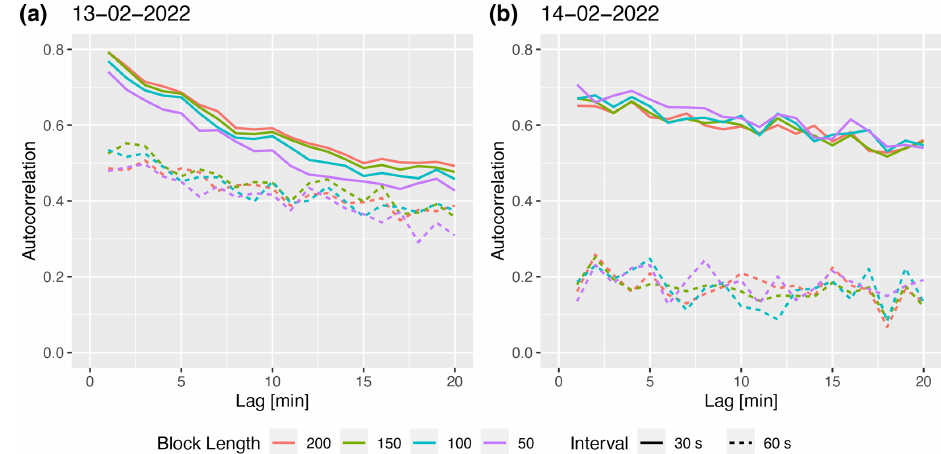
Figure 10. Autocorrelogram for U components for varying resolutions of the image with the same block region and the two frame intervals on 13 and 14 February 2022 shows the effect of the changing resolution and time intervals on the stability of the motion vectors.